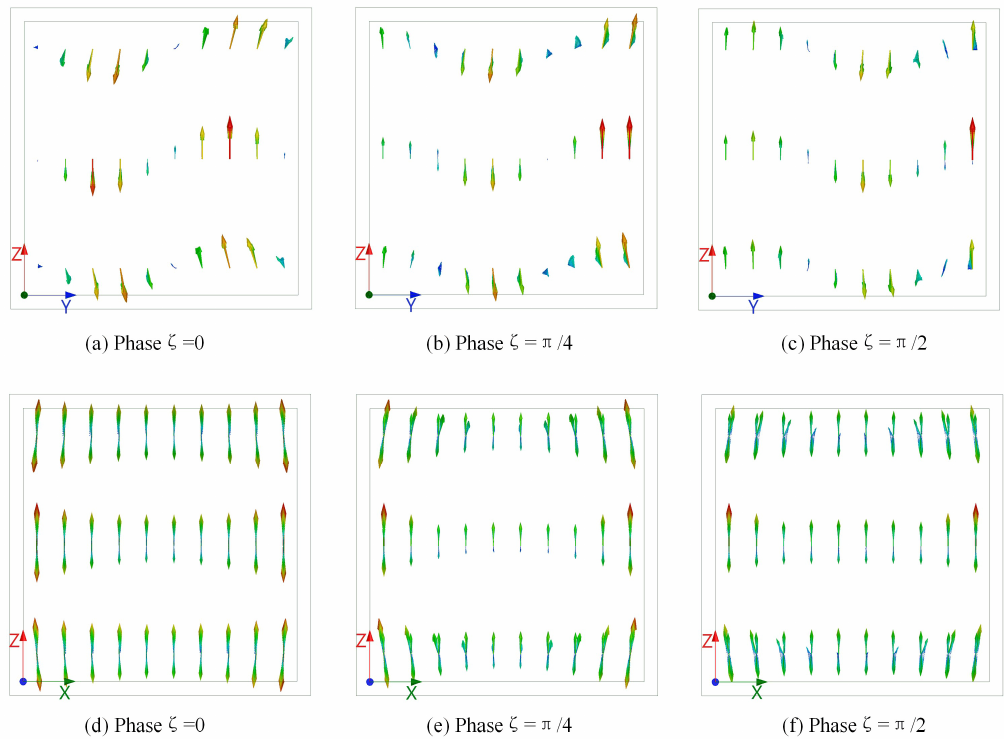
Figure 11. Simulation results of RF E-field vector distribution inside a 20 mm cuboidal vapor cell at 15 GHz. Vector distribution projecting on the yz -plane while observing along the x -axis, with relative phases of incident E-field of ( a ) 0, ( b ) π/4, and ( c ) π/2, respectively. Vector distribution projecting on the xz -plane while observing along the y -axis, with relative phases of ( d ) 0, ( e ) π/4, and ( f ) π/2.